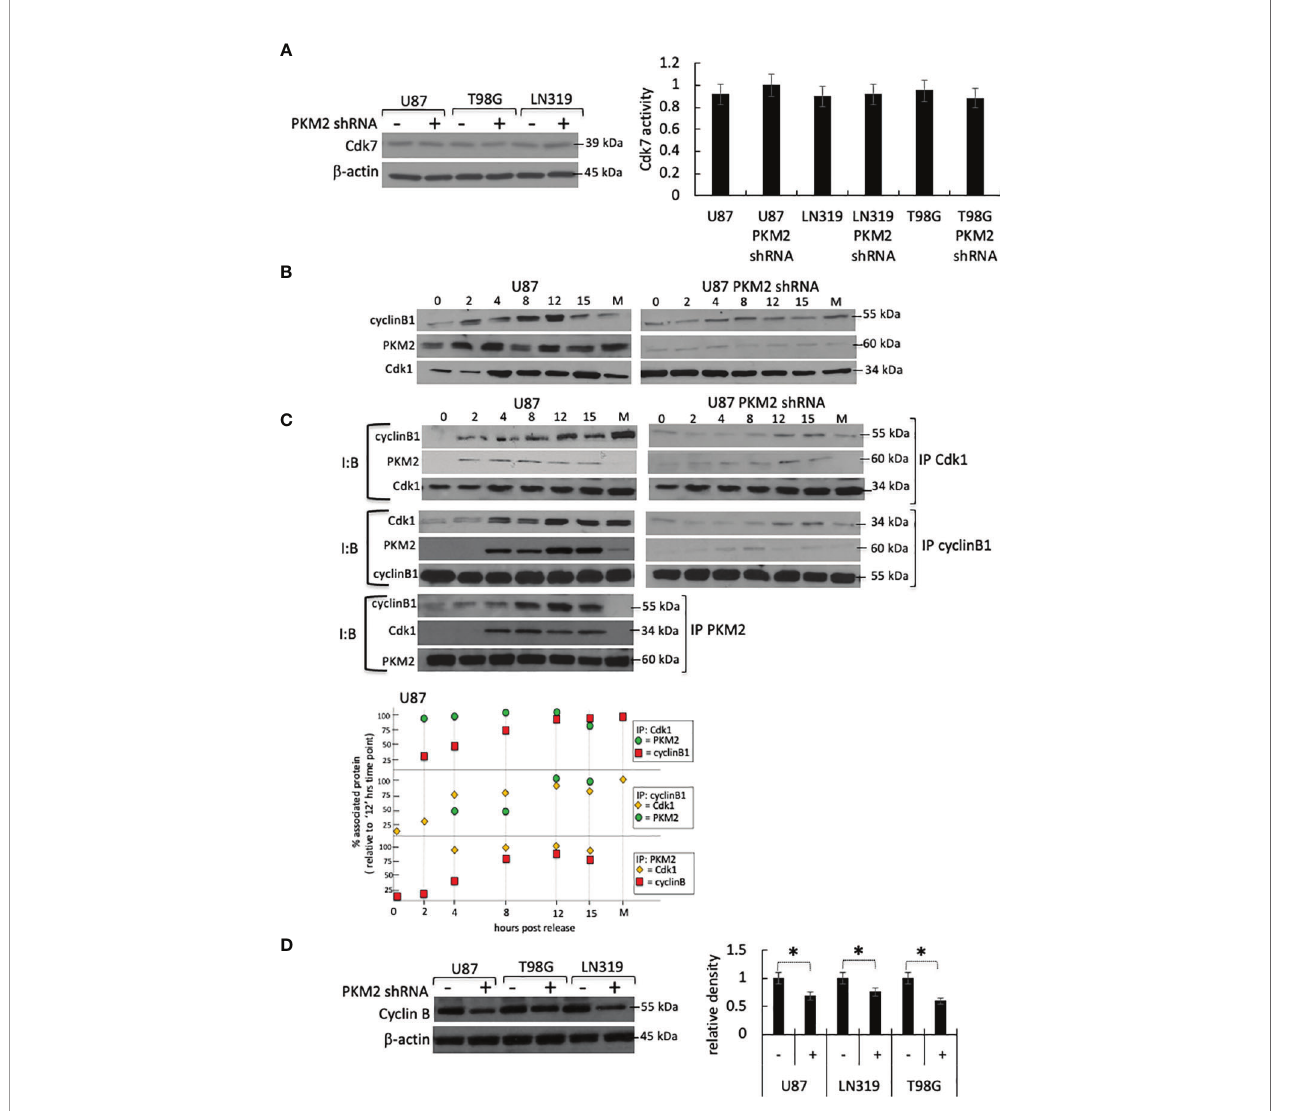
FIGURE 2 | PKM2 physically interacts with the Cdk1-cyclin B complex. (A) Levels (top) and activity (bottom) of Cdk7 in control and PKM2 knock-down U87, T98G and LN319 cells 10 hrs following release from serum deprivation-induced arrest. (B) Levels of cyclin B1, PKM2, and Cdk1 in total cell lysates in control or PKM2 shRNA U87 cells measured at the times indicated following release from serum deprivation-induced arrest. (C) Levels of Cdk1, cyclin B, or PKM2 from Cdk1, cyclin B or PKM2 immunoprecipitates measured at the times indicated following release of control or PKM2 shRNA U87 cells from serum deprivation-induced arrest. Data in M lanes were derived from cells isolated by mitotic shake-off. I:B = Immuno Blot, IP = immunoprecipitate. Bottom panel: Densitometric analysis of Cdk1, cyclin B, or PKM2 levels in U87 cells from Cdk1, cyclin B or PKM2 immunoprecipitates. (D) Western blot analysis of cyclin B1 in control and PKM2 knock-down U87, T98G and LN319 cells. Densitometric analysis (bottom right panel) of western blot demonstrating levels of cyclin B1 in different experimental groups. *p<.05,